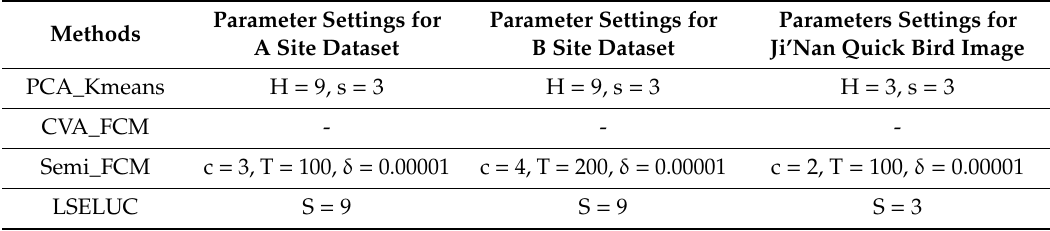
Table 3. Parameter settings for the comparison between the proposed framework and the state-of-the-art pre-processing LCCD approaches for the di ff erent datasets.